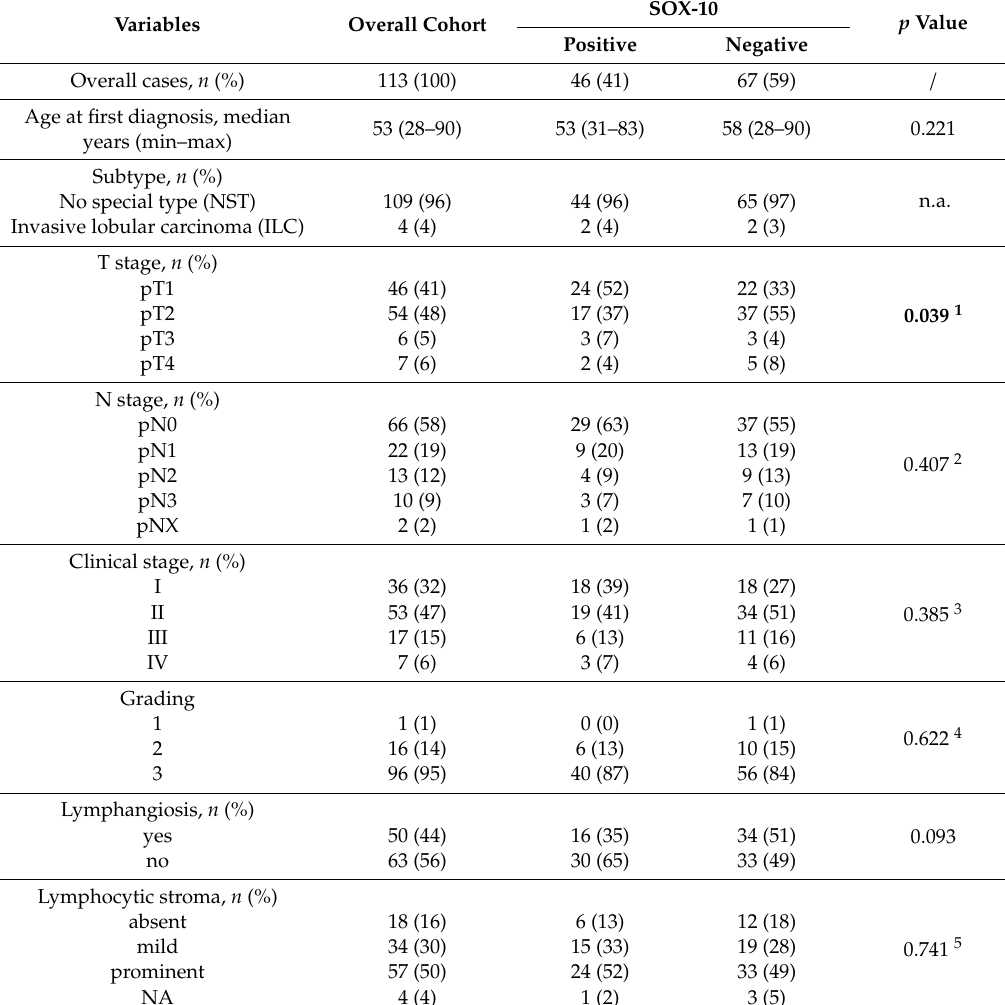
Table 1. Patients characteristics for the overall cohort and with regard to SOX-10